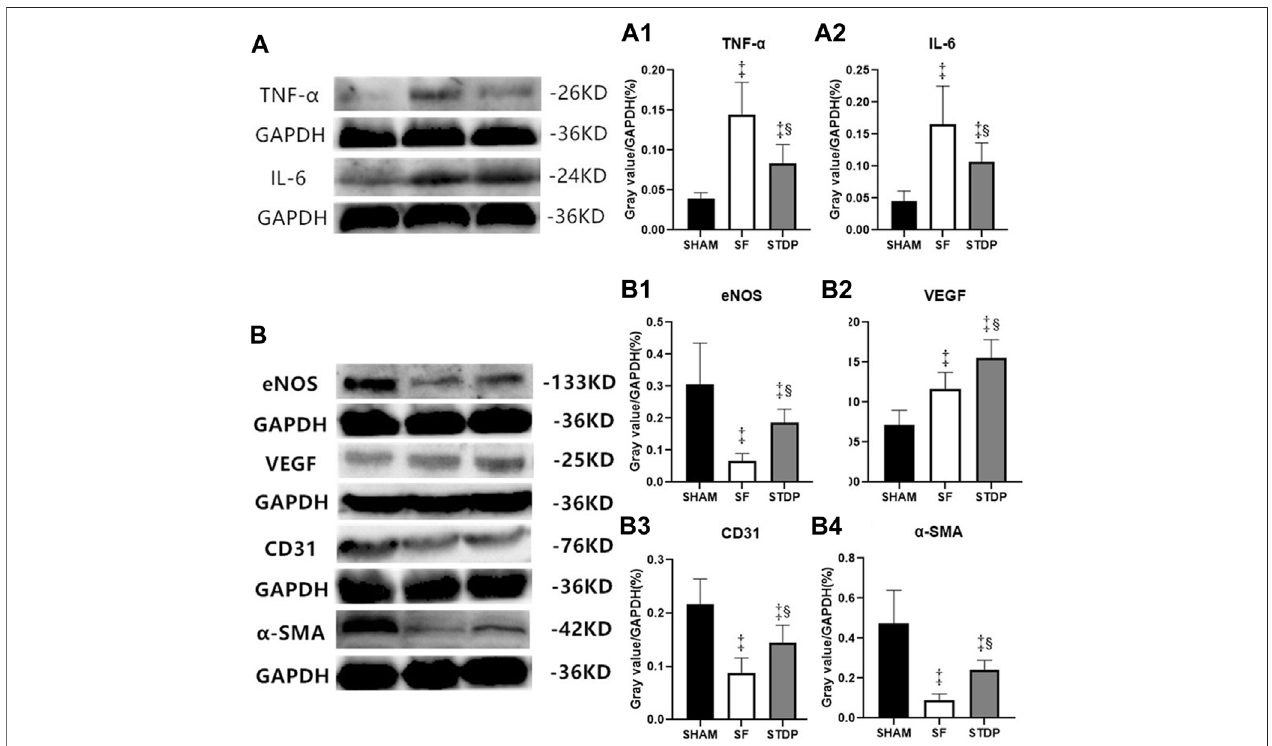
FIGURE7| TNF- ɑ ,IL-6,eNOS,VEGF,CD31,and ɑ -SMAinmyocardialtissueoftheischemiaareaanalyzedbyWesternblotting. (A) ExpressionsofTNF- ɑ andIL- 6 7 days after operation (A1) : Ratio of TNF- ɑ /GAPDH in different groups. (A2) : Ratio of IL-6/GAPDH in different groups. (B) Expressions of eNOS, VEGF, CD31, and ɑ - SMA 7 days after operation. (B1) : Ratio of eNOS/GAPDH in different groups. (B2) : Ratio of VEGF/GAPDH in different groups. (B3) : Ratio of CD31/GAPDH in different groups. (B4) : Ratio of ɑ -SMA/GAPDH in different groups. Data are presented as the mean ± SD. p < 0.05 ‡ vs. Sham group, and §vs. SF group ( n = 6 for each